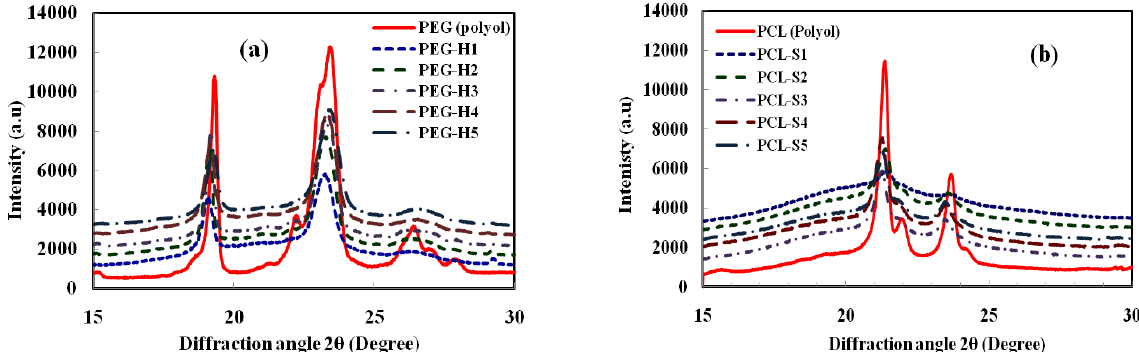
Figure 4. WAXD curves of the PEG ( a ) and PCL ( b )